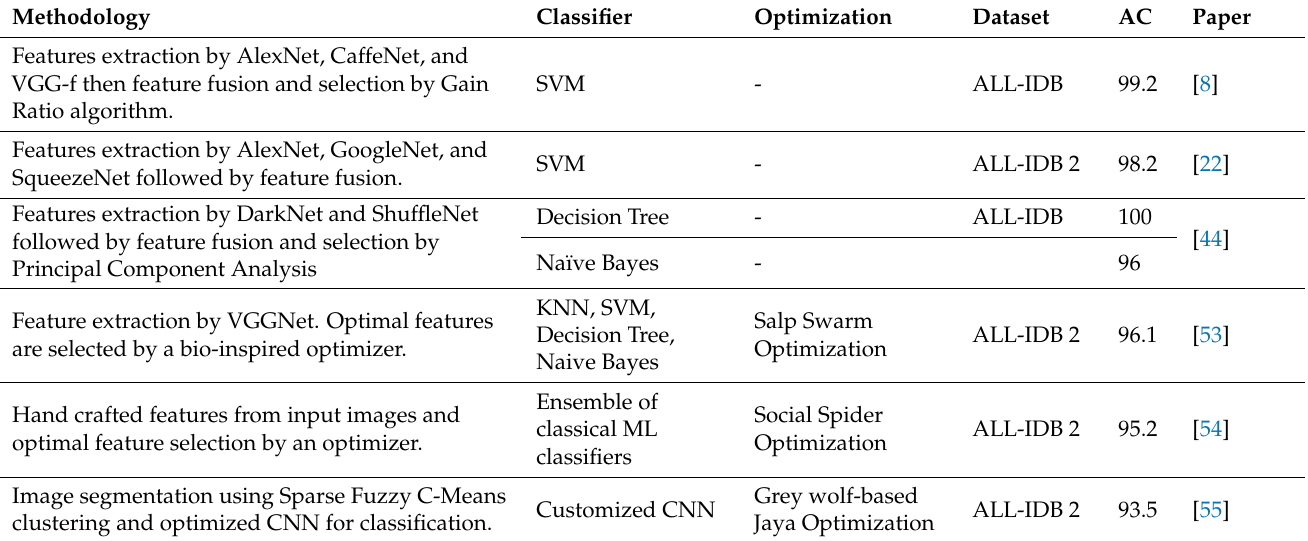
Table 4. Comparison results of the proposed Bayesian-based optimal CNN with the state-of the-art Leukemia detection systems. The accuracy is presented as